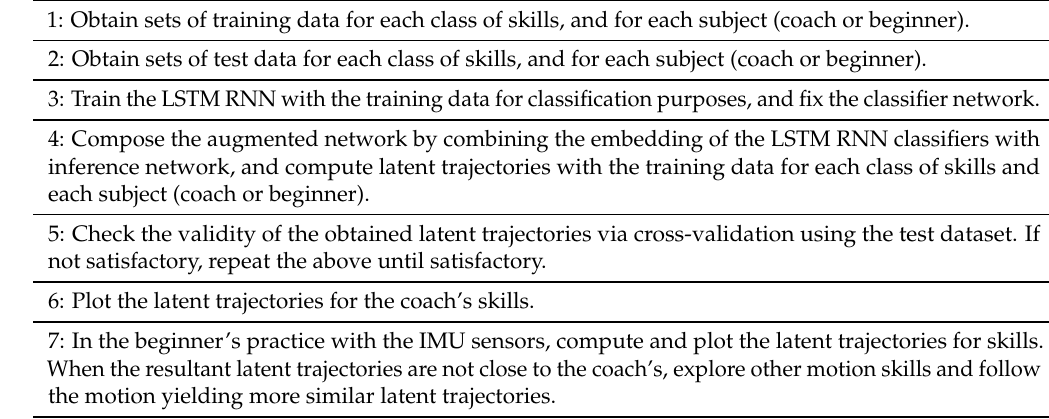
Table 5. Steps for the established training